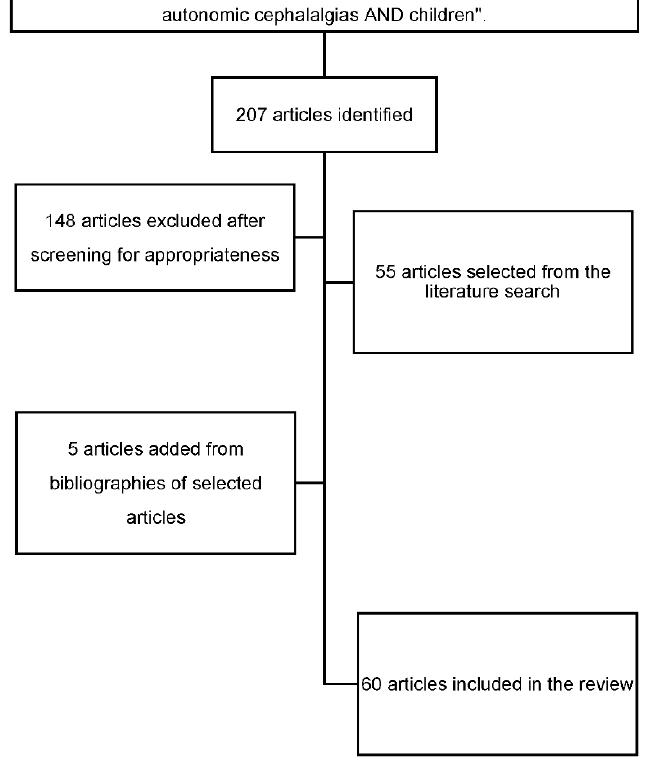
Figure 1. Flowchart of the study.